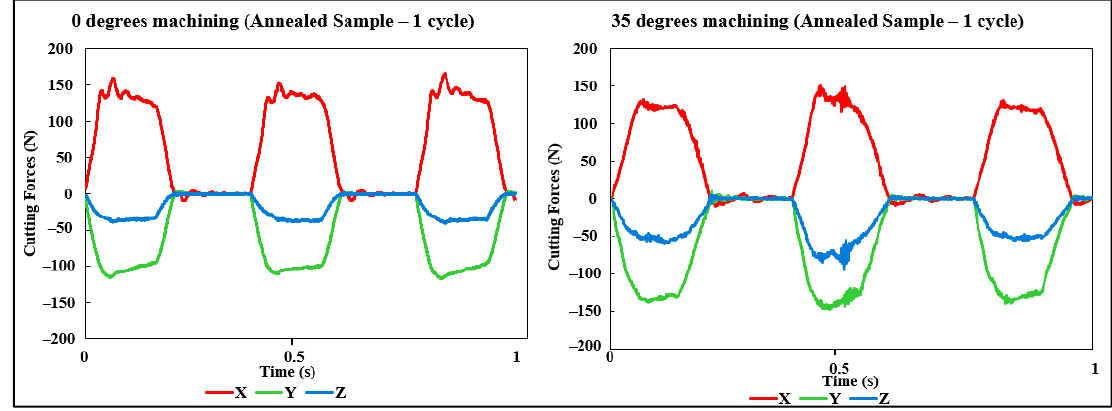
Figure 15. Cutting forces data—1 Cycle 0 and 35 degrees (Annealed Sample) .